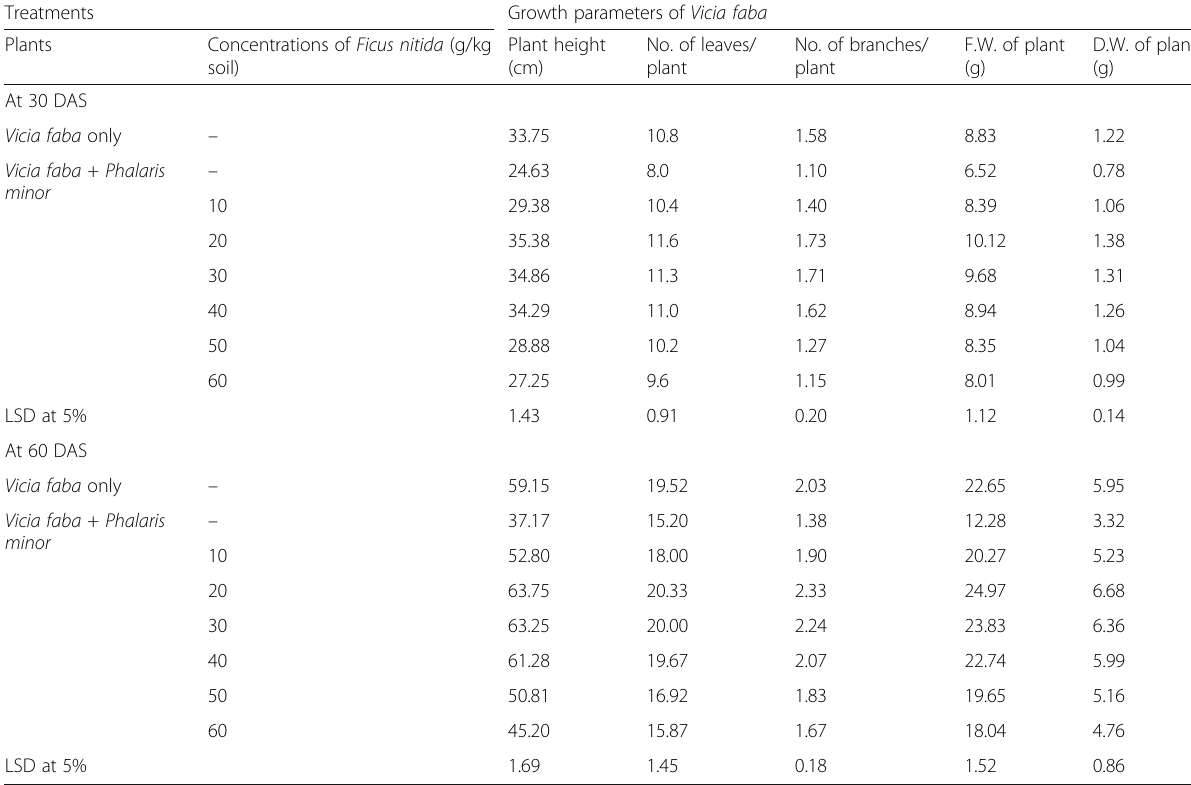
Table 3 Effect of Ficus nitida leaf powder on some growth parameters of Vicia faba plants associated with Phalaris minor at 30 and 60 days after sowing (average of the two seasons) Treatments Growth parameters of Vicia faba Plants Concentrations of Ficus nitida (g/kg soil)